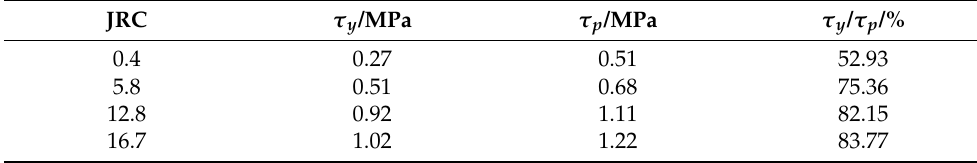
Figure 16. Yield stresses under the high velocity impact (Note: τ p data are from Fan et al. [80]).